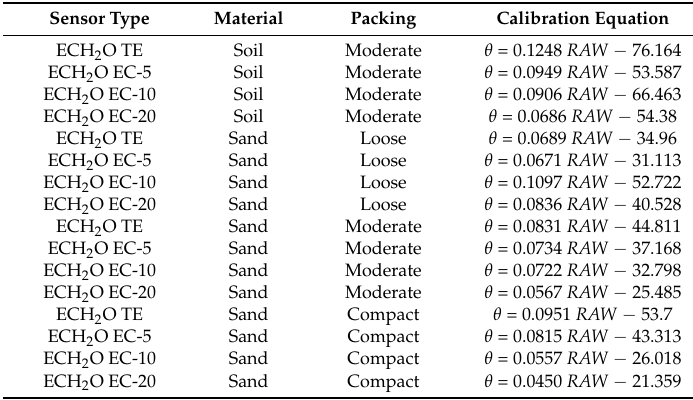
Table 6. Our own linear calibration equations for sensors from the ECH 2 O family (RAW is the sensor output in mV and θ is water content in vol